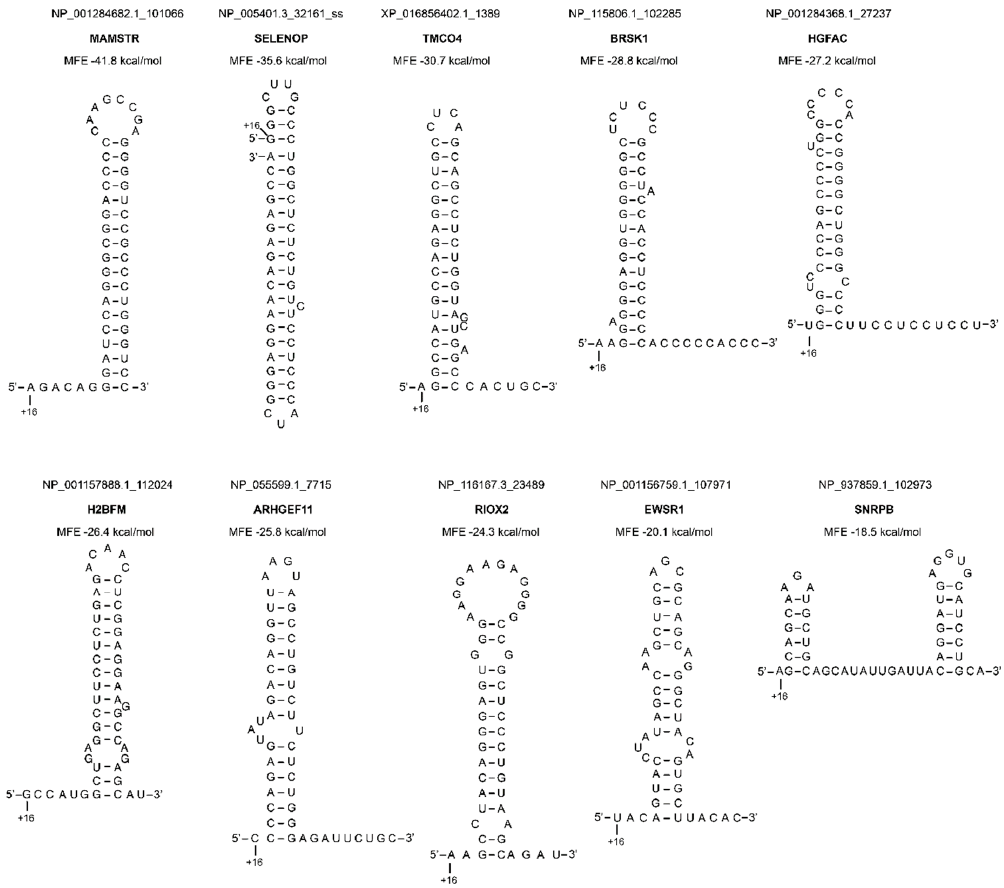
Figure 6. Representation of the ten best secondary structures selected in the human genome. The position of nucleotide +16 is indicated. The names of the genes are shown in bold.